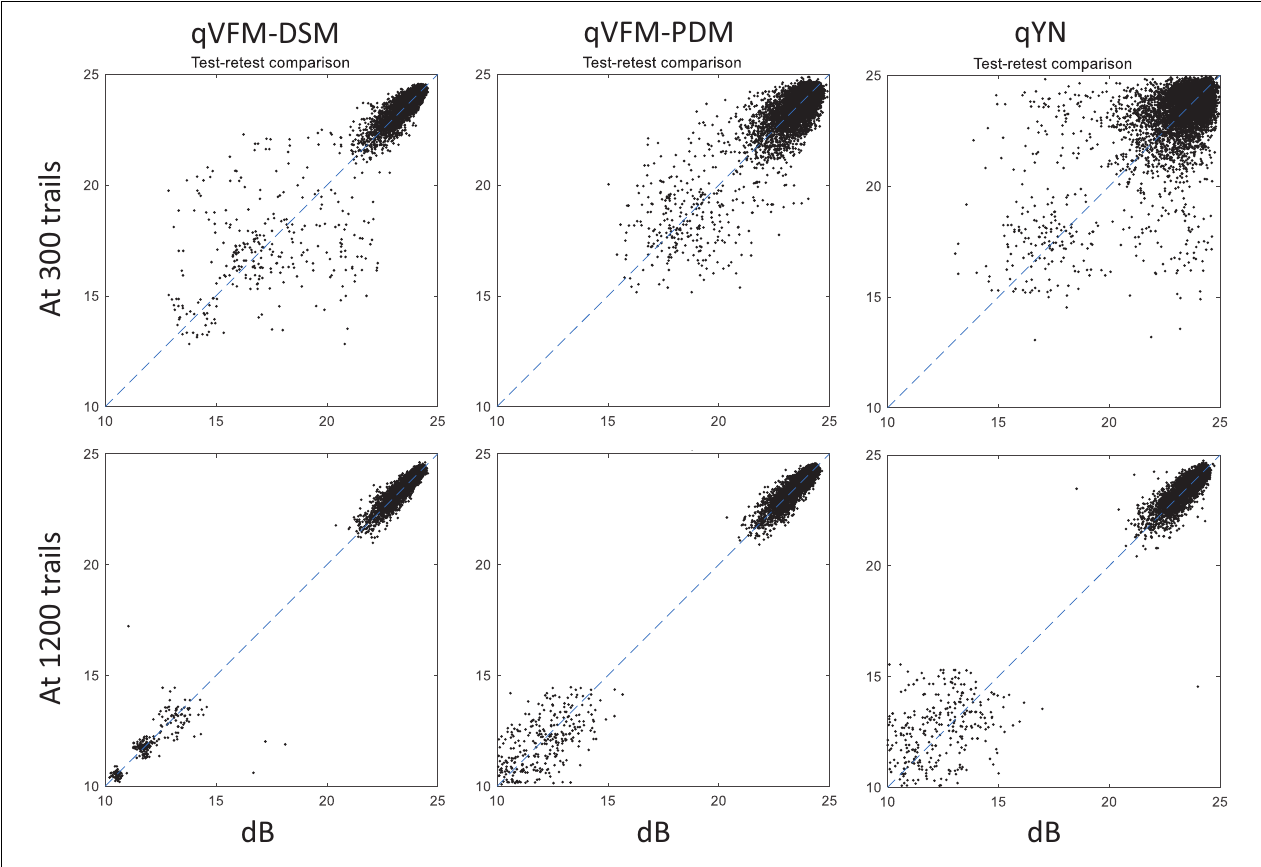
FIGURE 4 | Performance II of the qVFM-DSM, qVFM-PDM, and qYN methods in estimating VFM of the simulated scotoma observer. Test-retest comparison of the estimated light sensitivities from repeated 200 runs at 300 and 1,200 trials.